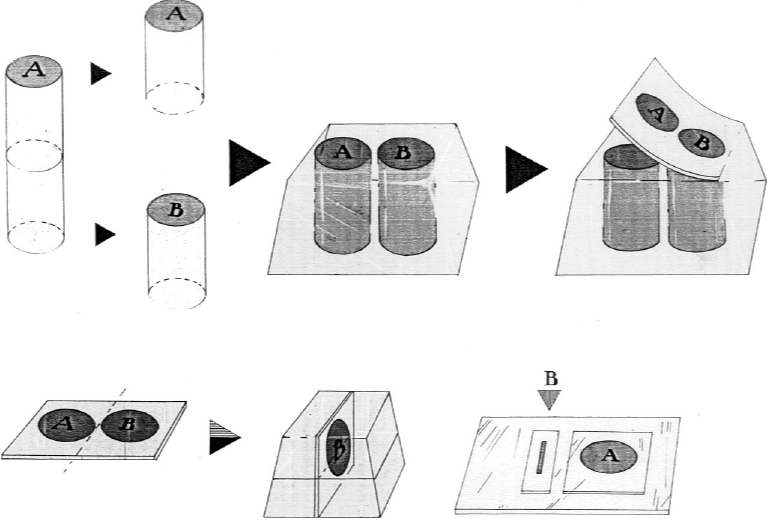
Fig. 2. Schematic representation of the steps followed to measure the optical density and the actual section thickness of a PAS-cylinder. (See text for explanation.) This procedure was repeated with sections of 3, 5, 7, 10, 15 and 20 (cid:22) m in thickness from the same